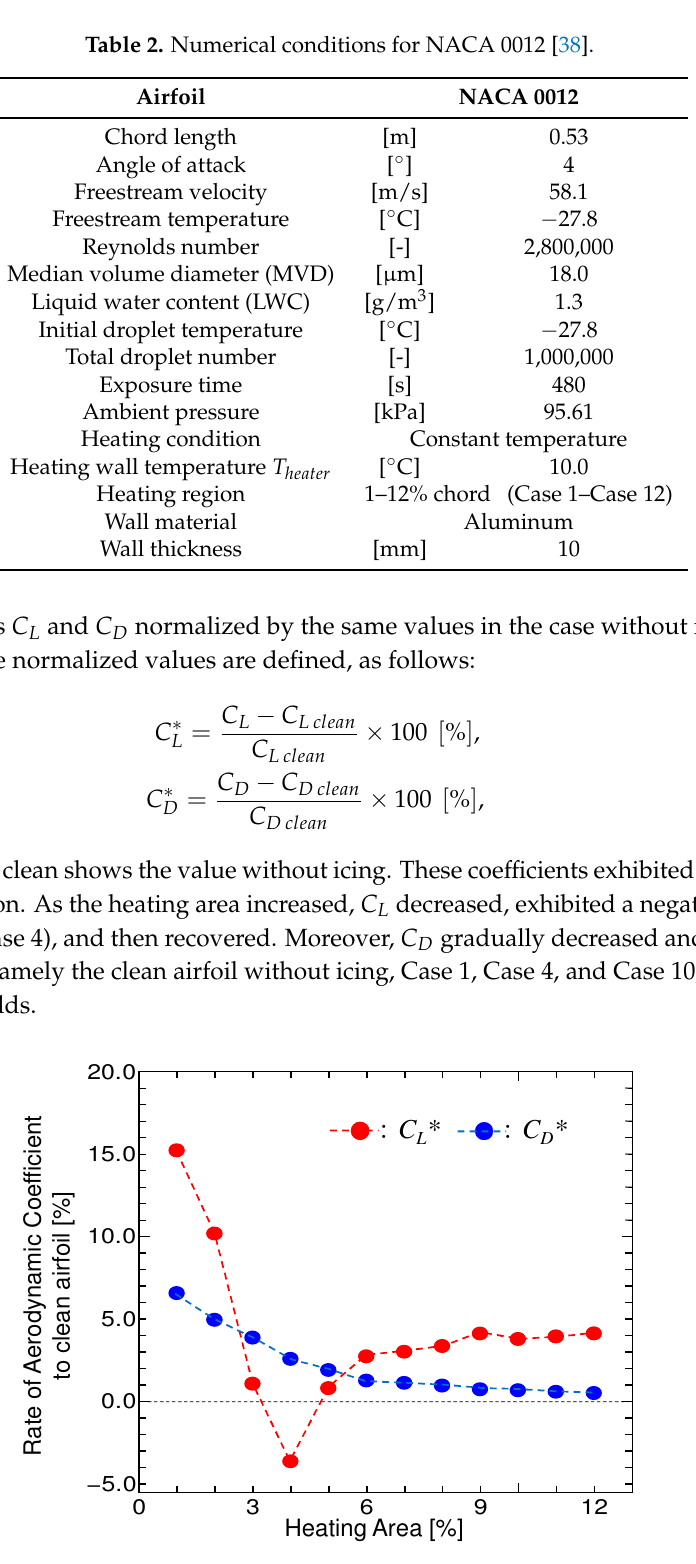
Figure 7. Aerodynamic performance of each heating area against performance of clean